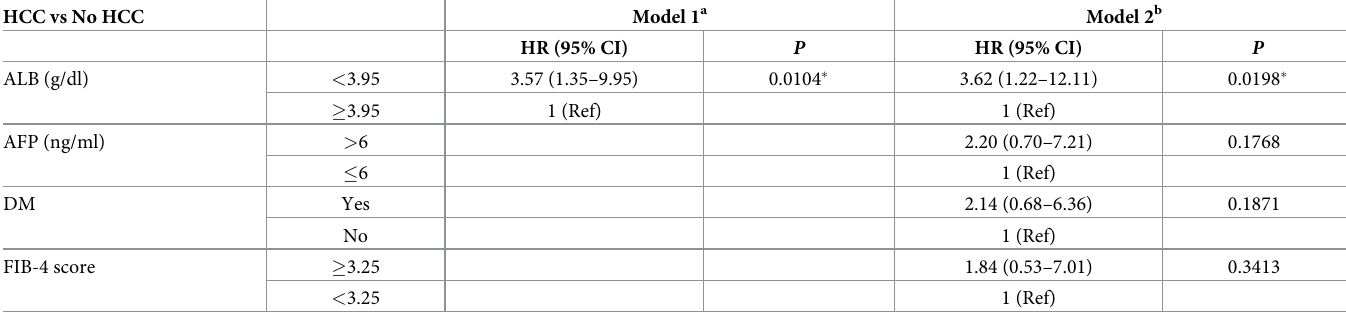
Table 3. Factors associated with the development of HCC after DAA treatment in HCV-positive patients without cirrhosis by Cox multivariate model. HCC vs No